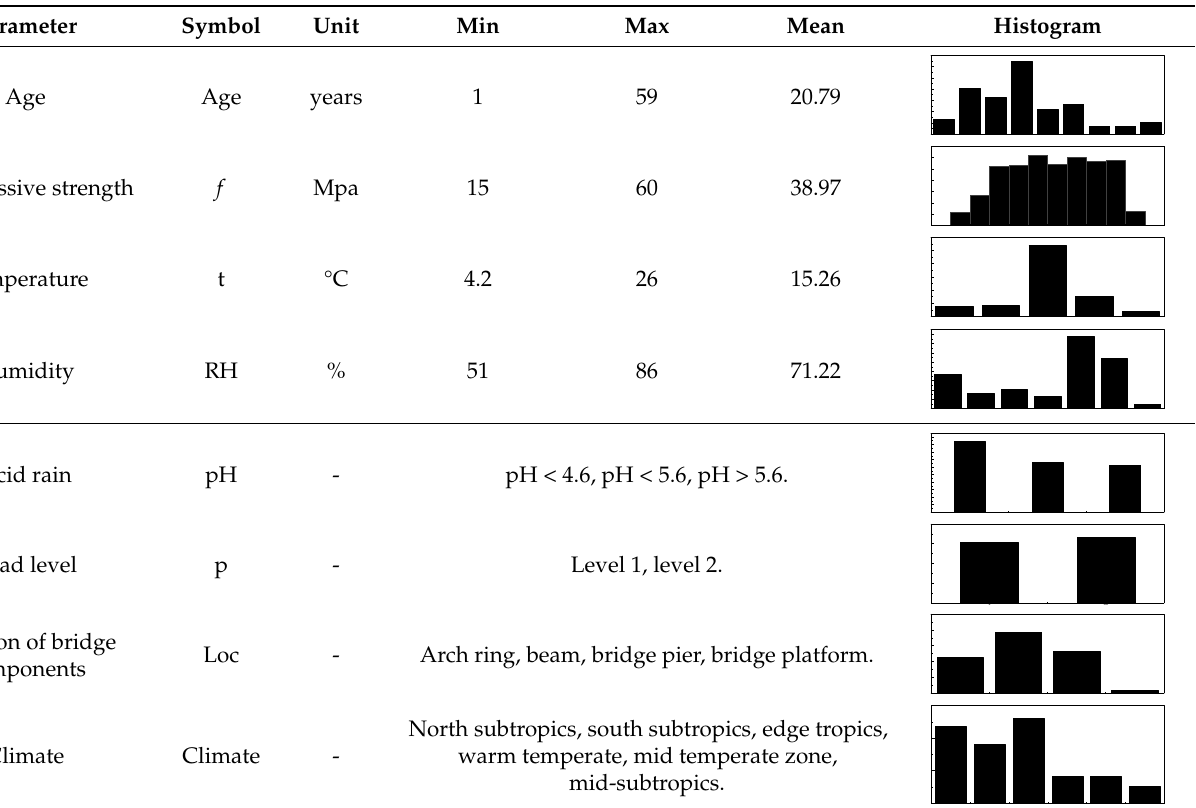
Figure 1. The distribution of the bridges involved in this study. Table 1. Detailed information of the dataset.